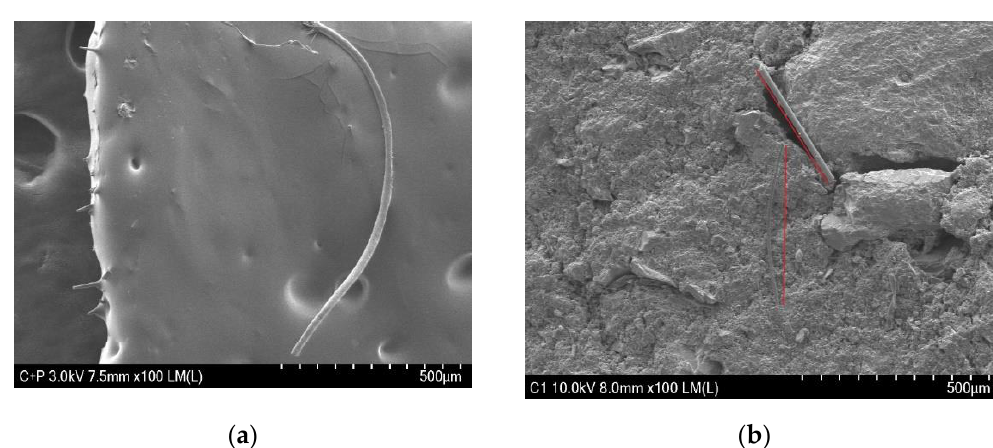
. Figure 13. SEM micrograph of an AC mixture with fiber after indirect tensile strength (IDT) testing . 4. Conclusions This paper studied the performance of glass wool fibers in a dense-graded AC mixture. Glass wool fibers were added into the AC mixture together with an asphalt binder and aggregates. Laboratory tests, Marshall mix design, indirect tensile strength, tensile strength ratio and the Kim test were conducted to evaluate the effect of adding fibers to the AC. The following results were obtained based on laboratory investigations. 1.